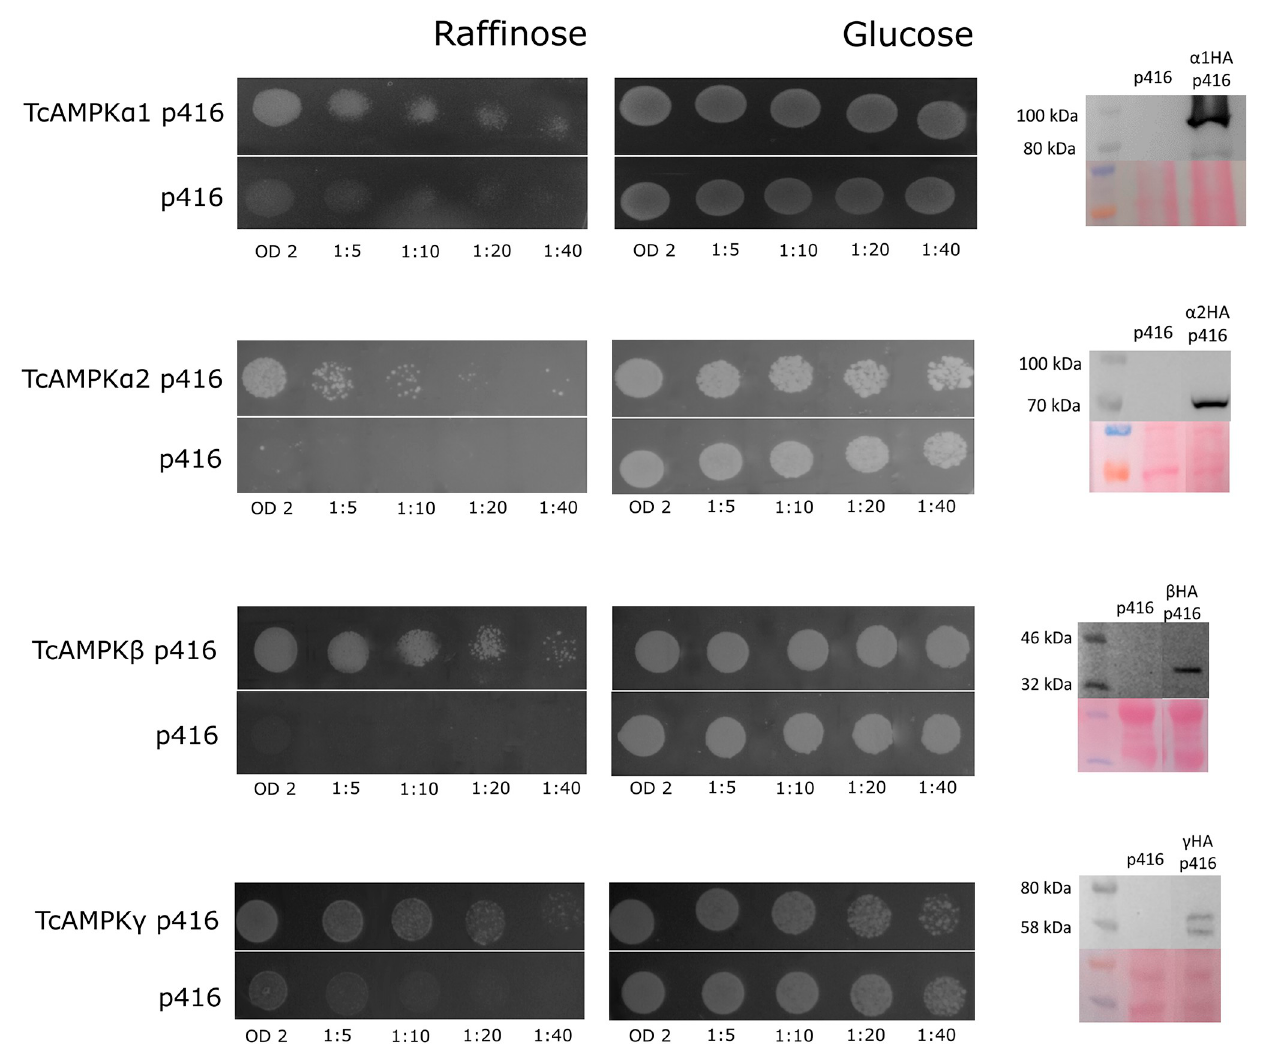
Fig 2. TcAMPK subunits can complement S . cerevisiae conditional mutants deficient in SNF1 subunits. Transformed yeast were plated in serial dilutions on minimal medium containing an Uracil drop-out and either glucose or raffinose as the only carbon source. Transformation of the conditional mutant yeasts with TcAMPK subunits restored the wild type phenotype, enabling the consumption of raffinose as a carbon source. The yeast containing the empty p416 plasmid could not grow on medium containing raffinose. Western blots at the right margin show at the upper panels the expression of the heterologous construct and bottom panels correspond to Ponceau staining as loading